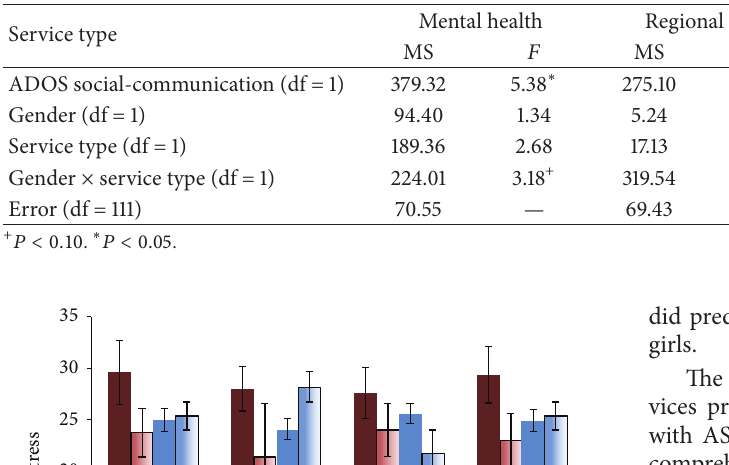
Table 3: ANOVA examining differences in parental distress based on receipt of each service type.